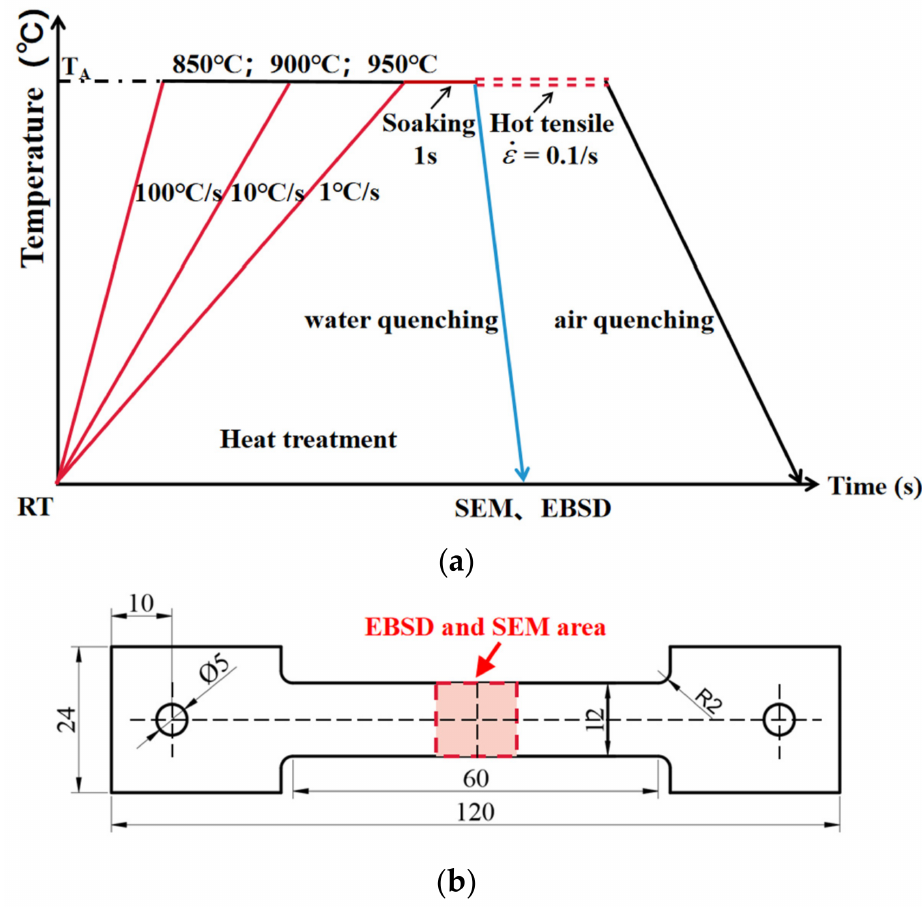
Figure 2. ( a ) Temperature profiles of the Gleeble hot tensile and heat treatment tests; ( b ) Geometries of Gleeble hot tensile tests and microstructure